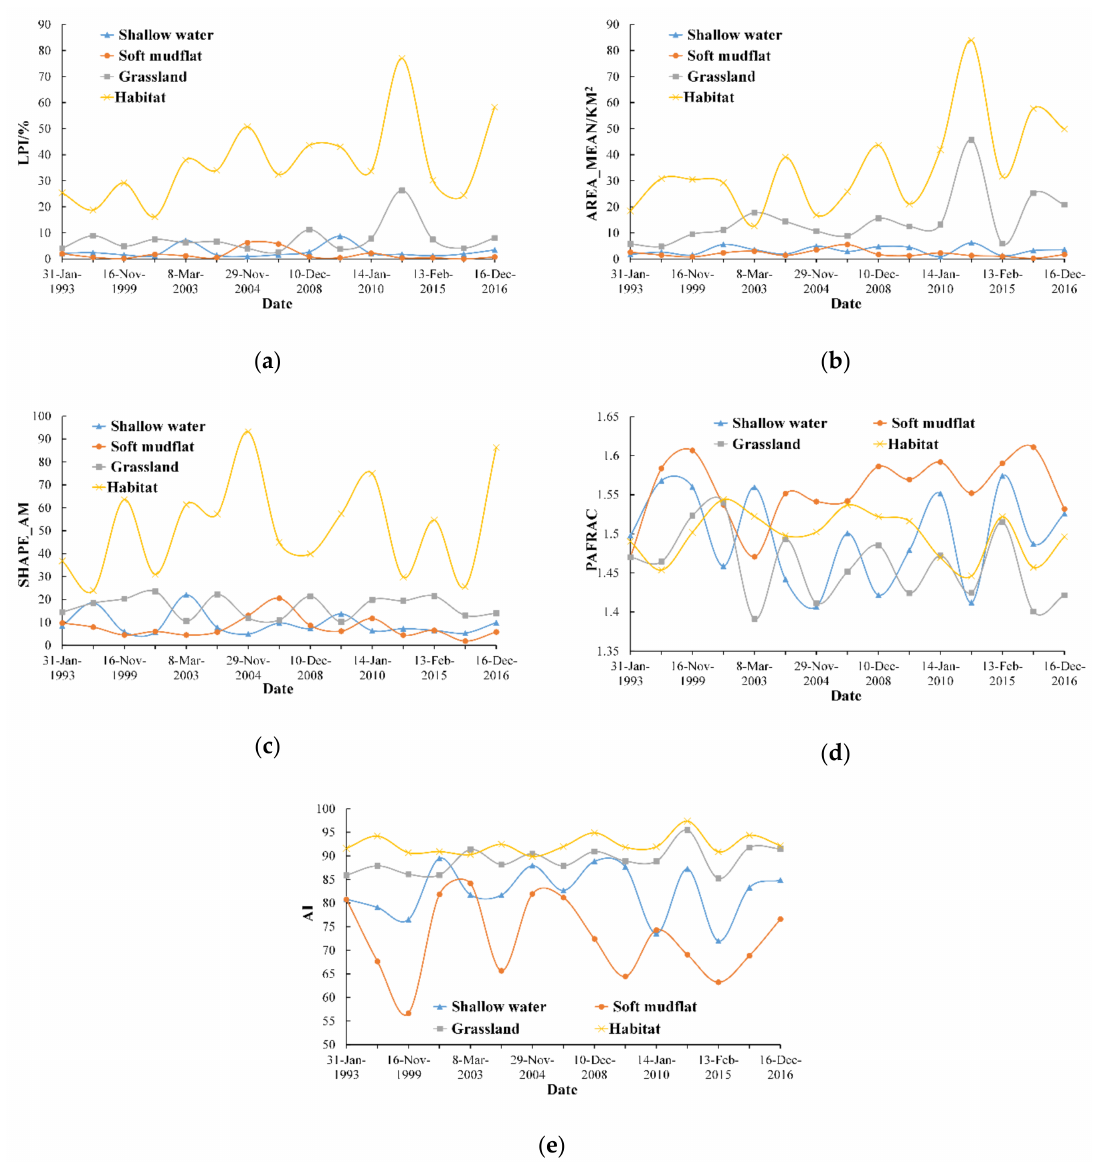
Figure 4. Temporal changes of landscape metrics of the crane habitats in the Poyang Lake wetland: ( a ) LPI; ( b ) AREA_MEAN; ( c ) SHAPE_AM; ( d ) PAFRAC; ( e )